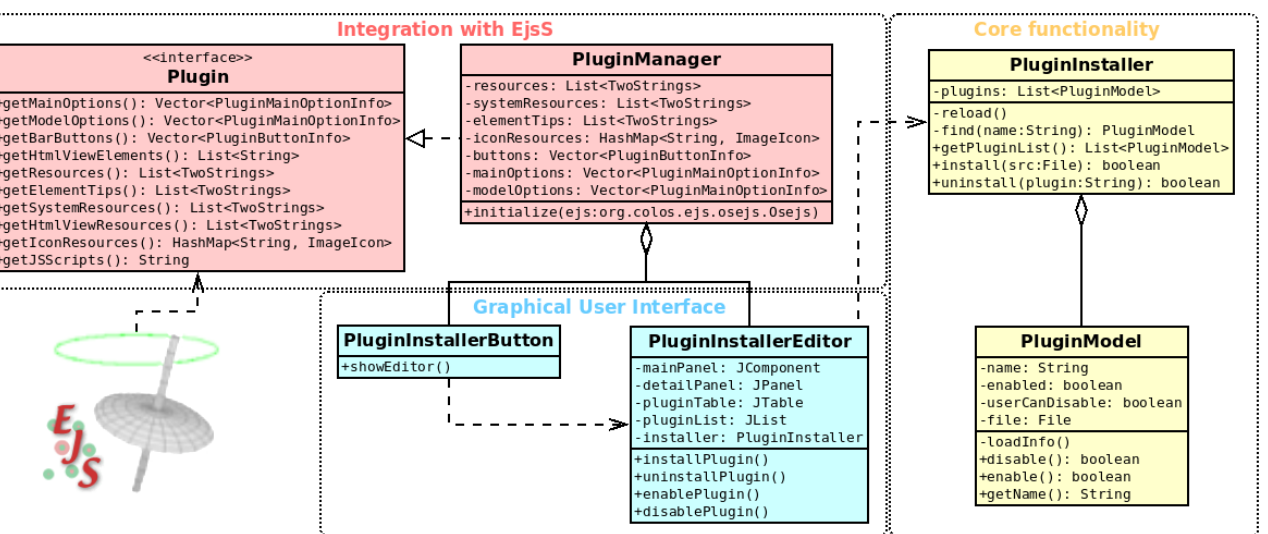
Figure 4. UML class diagram of the Plugin